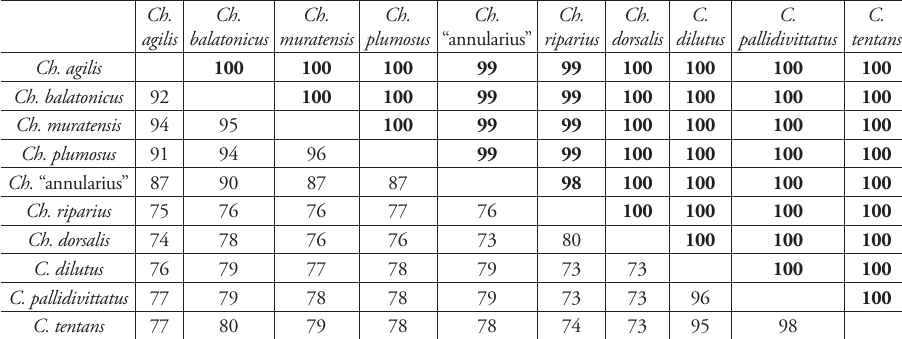
Table 2. The percent of identity between 5.8S rDNA nucleotide sequences (above) and ITS-1 (below) in Chironomus